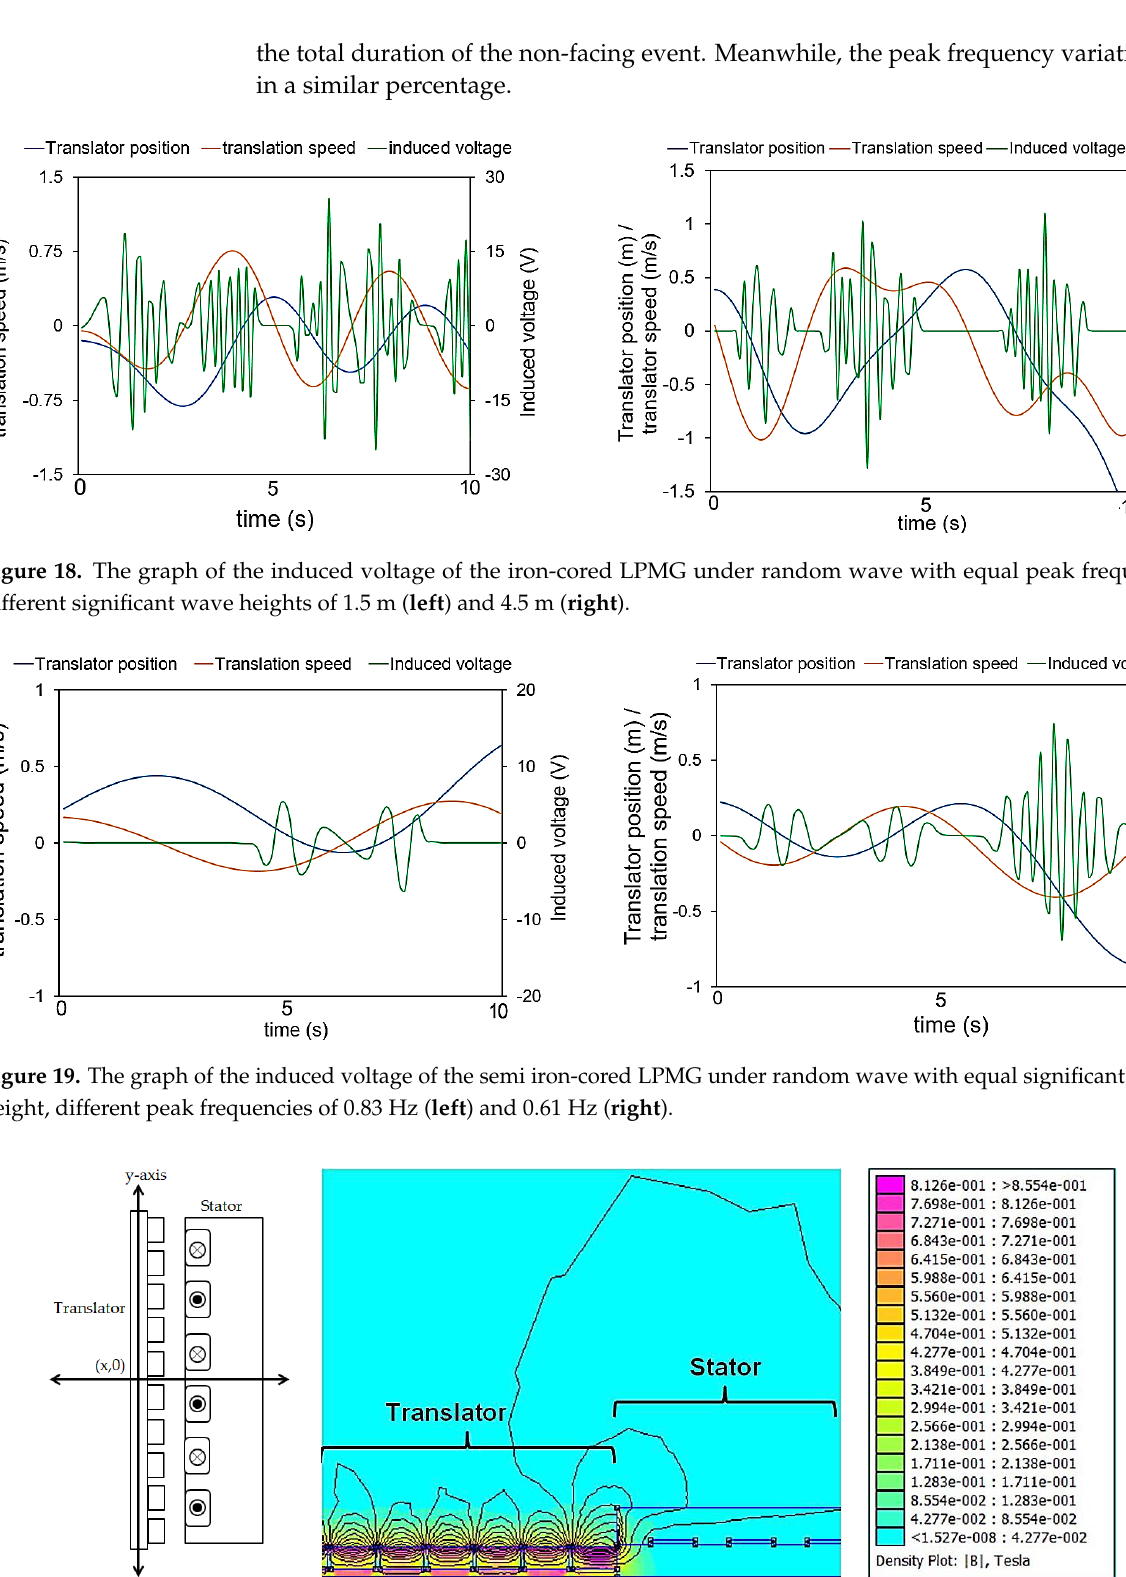
Figure 21. The duration percentages of the non-facing event and the facing event under a random wave with different significant wave height ( left ) and peak frequency ( right ). Then, from the induced voltage, the output power can be calculated. Figure 22 shows the output power graphs from both LPMG designs under different random wave config- urations. They make irregular forms with several disjoints (where the output values are close to zero) due to the non-facing events. Previously, the disjointed graphs were also resulted under regular wave tests [44]. The design process under sinusoidal wave as- sumption allowed the translator length to be shorter than the wave amplitude, thus caus- ing the events. In the next explanations, the output power will be analyzed in two aspects: maximum and effective (root mean square) values. The first is a measure of the system’s ability to produce as maximum output power as possible. Meanwhile, the latter value is used to analyze the overall delivered output power considering the limited and fixed di- mension of the LPMG as well as the irregular wave forms. Figures 23 and 24 show the effective and maximum output powers of both LPMGs under different wave variations for various load resistances. Then, the values for all con- figurations are tabulated in Table 7. In previous induced voltage in random waves’ dis- cussion, the resulted voltage is affected by two factors: the instantaneous translation speed that moves the translator and the translator position itself. Therefore, the output power